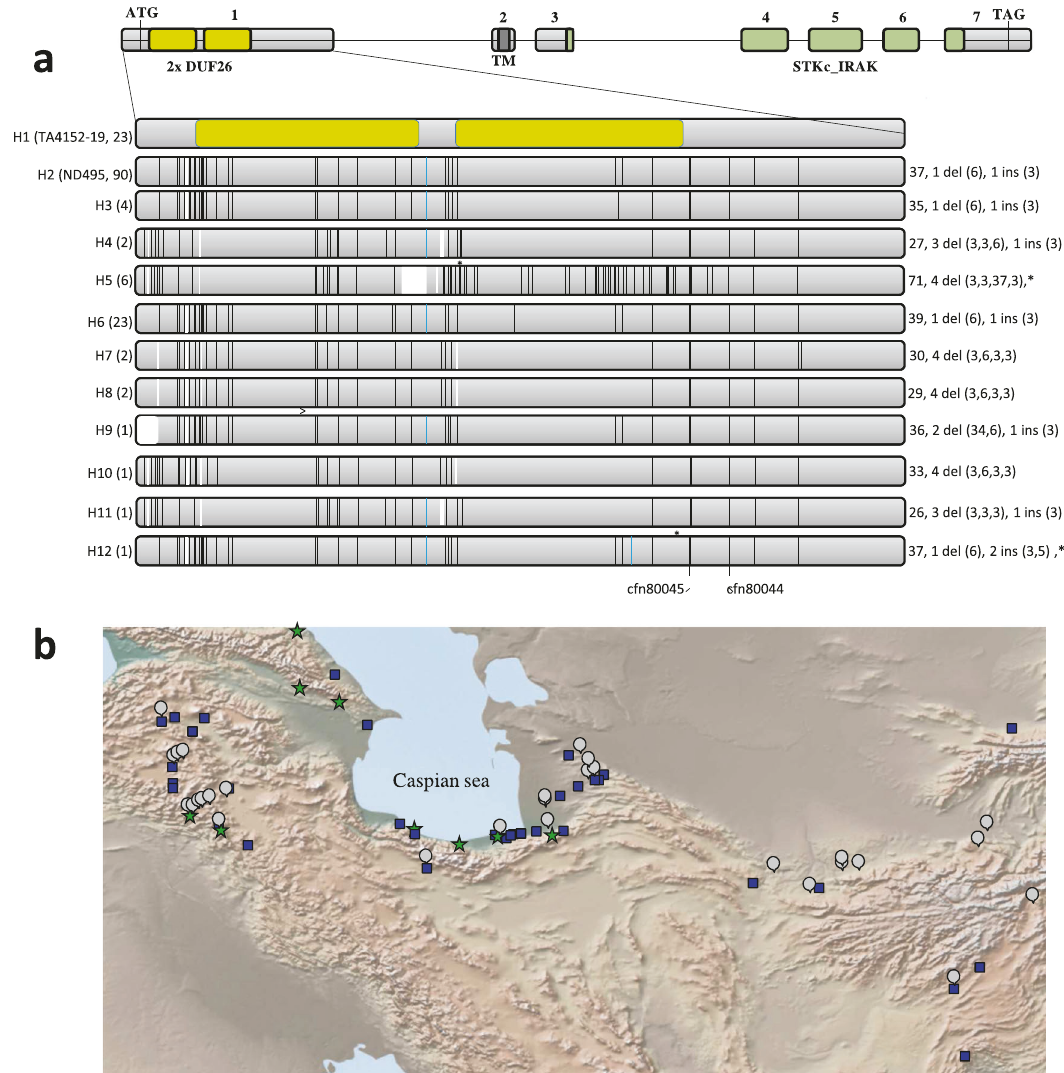
Fig. 2 Stb16q genetic diversity and origin. a Schematic representation of the 12 Stb16q exon1 haplotypes (H1 from H12) identi fi ed from re-sequencing 156 wheat accessions (including the 76SHWs, Supplementary Data 4). Stb16q structure reveals seven exons indicated as light gray boxes. Yellow, dark gray, and green boxes represent the predicted DUF26 domains, the transmembrane domain, and the serine/threonine protein kinase, interleukin-1 receptor associated kinase (STKc_IRAK) domains, respectively. Vertical black, white, and blue bars represent SNP, deletions, and insertions, respectively, compared to haplotype 1. On the left of each haplotype are indicated in brackets the most relevant representative and the number of accessions identi fi ed for each haplotype. On the right of haplotypes are indicated the number of SNP, number of deletions (their size in bp), and number of insertions (their size in bp). Asterisks highlight the presence of a stop codon. Physical position of diagnostic markers cfn80044 and cfn80045 are indicated at the bottom. All haplotypes have been identi fi ed in the SHWs collection except haplotype H12. b Topographic distribution of Ae. tauschii accessions carrying the Stb16q gene (green star) or not (blue square) and undetermined allele (gray round) according to diagnostic markers cfn80044 and cfn80045 (Supplementary Data 6). The map was created using the GPS Visualizer software